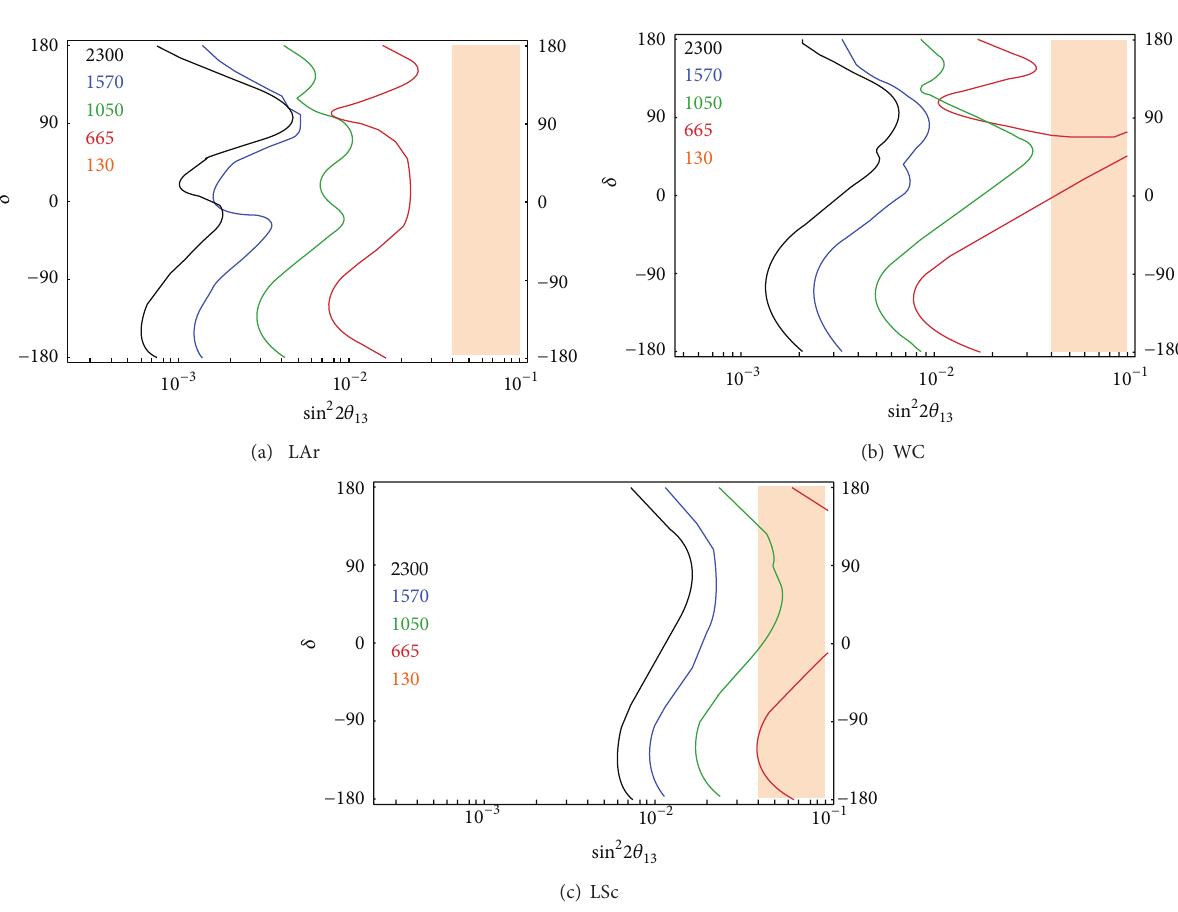
Figure11:LAGUNAhierarchydiscoveryat 3𝜎 asafunctionofsin 2 2𝜃 13 and 𝛿 .Thedifferentlinescorrespondtodifferentbaselines,asindicated in the legend in km. The details of the beams used are reported in the text. The detectors are 100kton LAr TPC, 50 kton LSc, and 440 WC detector. The shaded region reports the 3𝜎 allowed values from Daya Bay. Figure is taken from